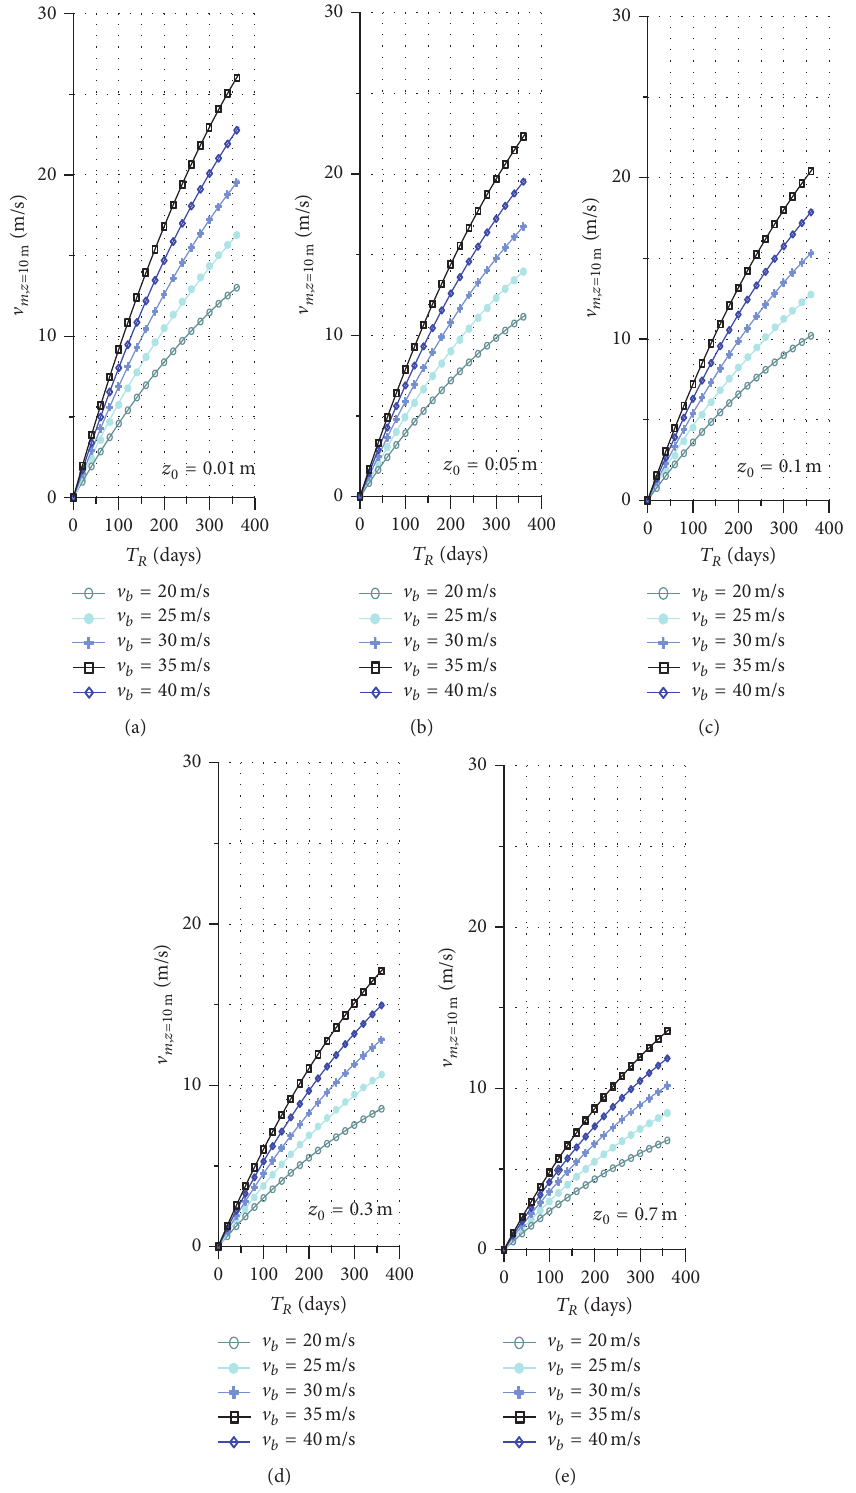
Figure 4: Values of 10-minute mean wind velocity at 10m height as a function of the return period, 𝑇 𝑅 , for 𝑇 𝑅 smaller than one year for terrain categories I (a), II (b), III (c), IV (d), and V